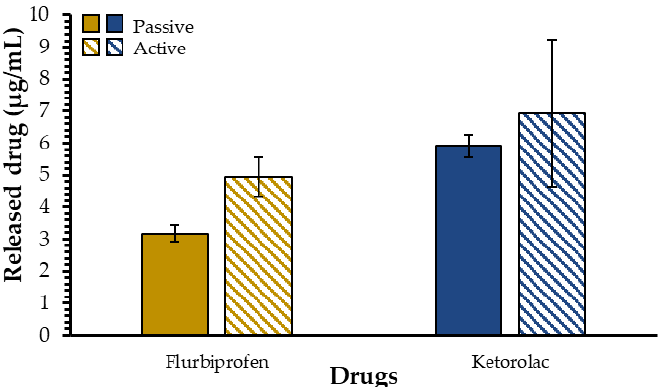
Figure 5. Comparison between the active and passive drug release protocols using a loading ratio of 1:50 and a 3-day loading time.